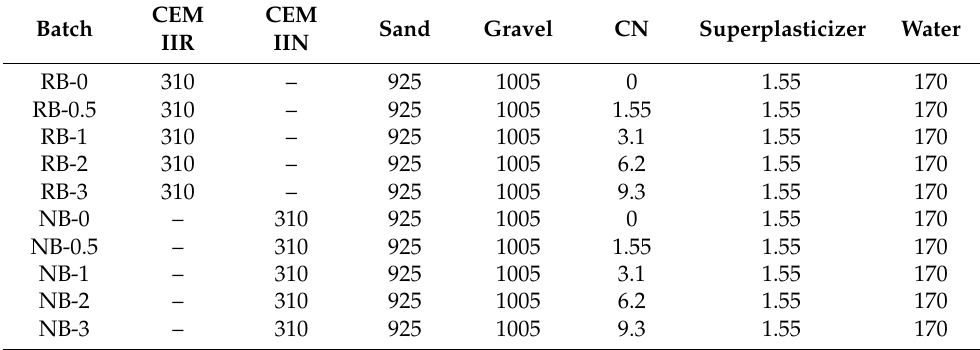
Table 4. Quantity (in kg) of raw materials necessary to prepare 1 m 3 of